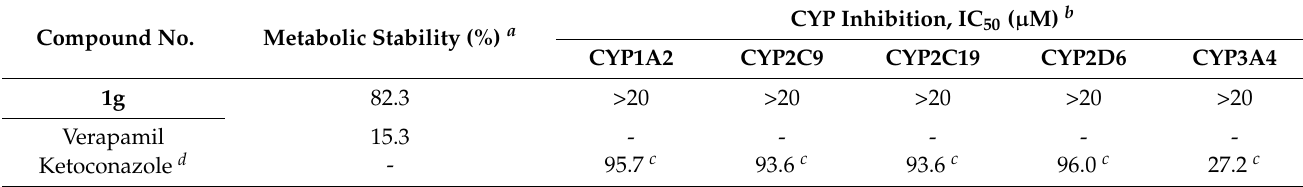
Table 2. Human liver microsomal stability and CYP isozyme inhibition activity of 1g . Compound